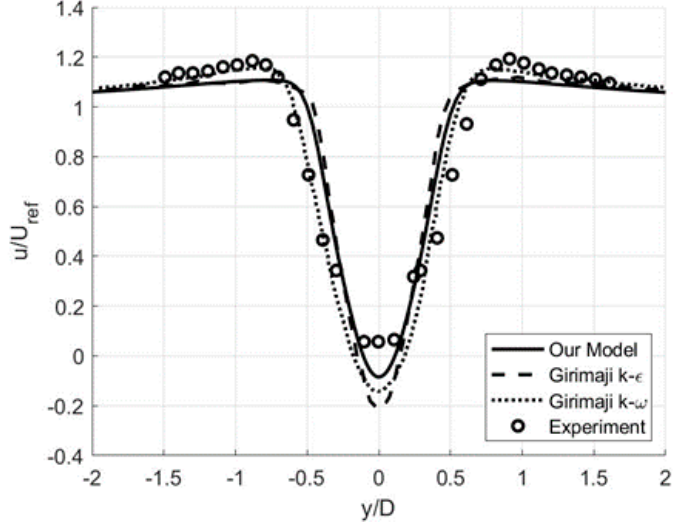
Figure 16. The mean streamwise velocity profile at x / D = 1 (𝑓 (cid:3084) = 1.0, 𝑓 (cid:3038) = 0.7).